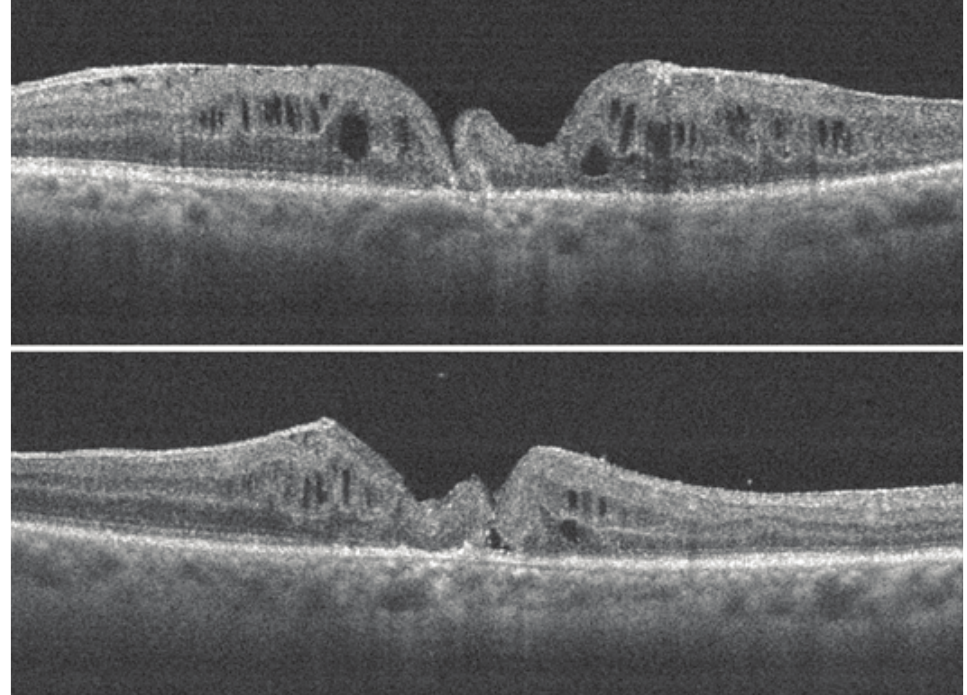
Figure 6. Patient 2; later postoperative OCT cross-line horizontal and vertical scans with retraction of the retinal graft. There is a gap between the edge of the graft and the macular hole.